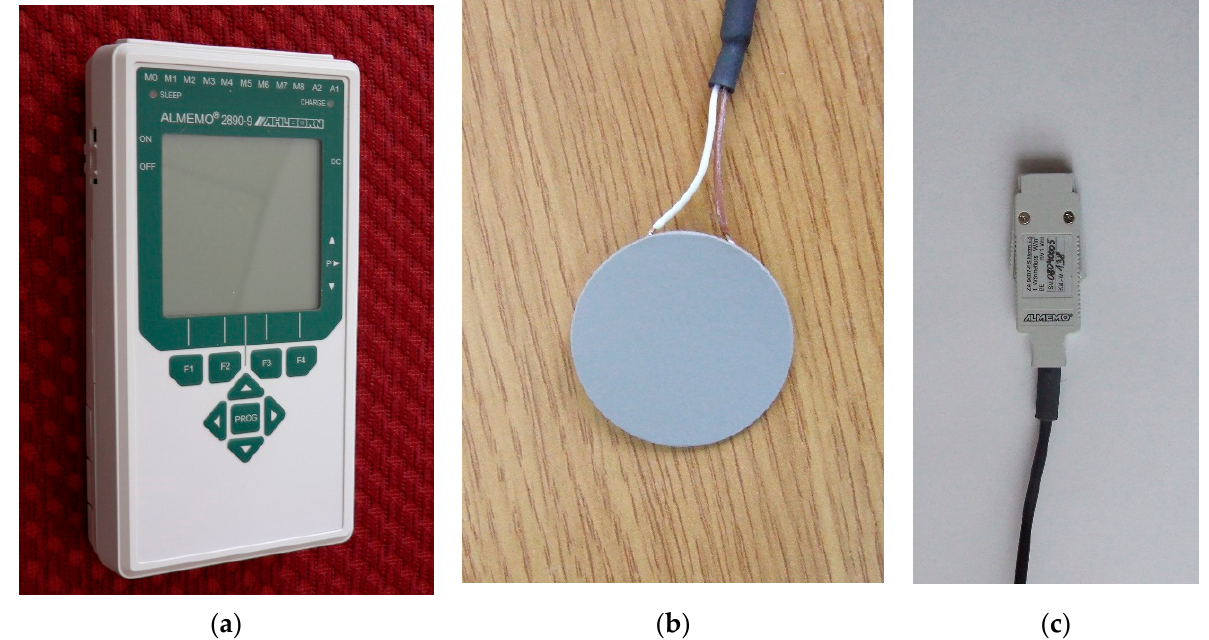
Figure 8. Measurement devices: ( a ) multi-channel recorder for saving measurement results; ( b ) sensor for measuring the heat flux density and temperature; ( c ) sensor plug with compensation system.